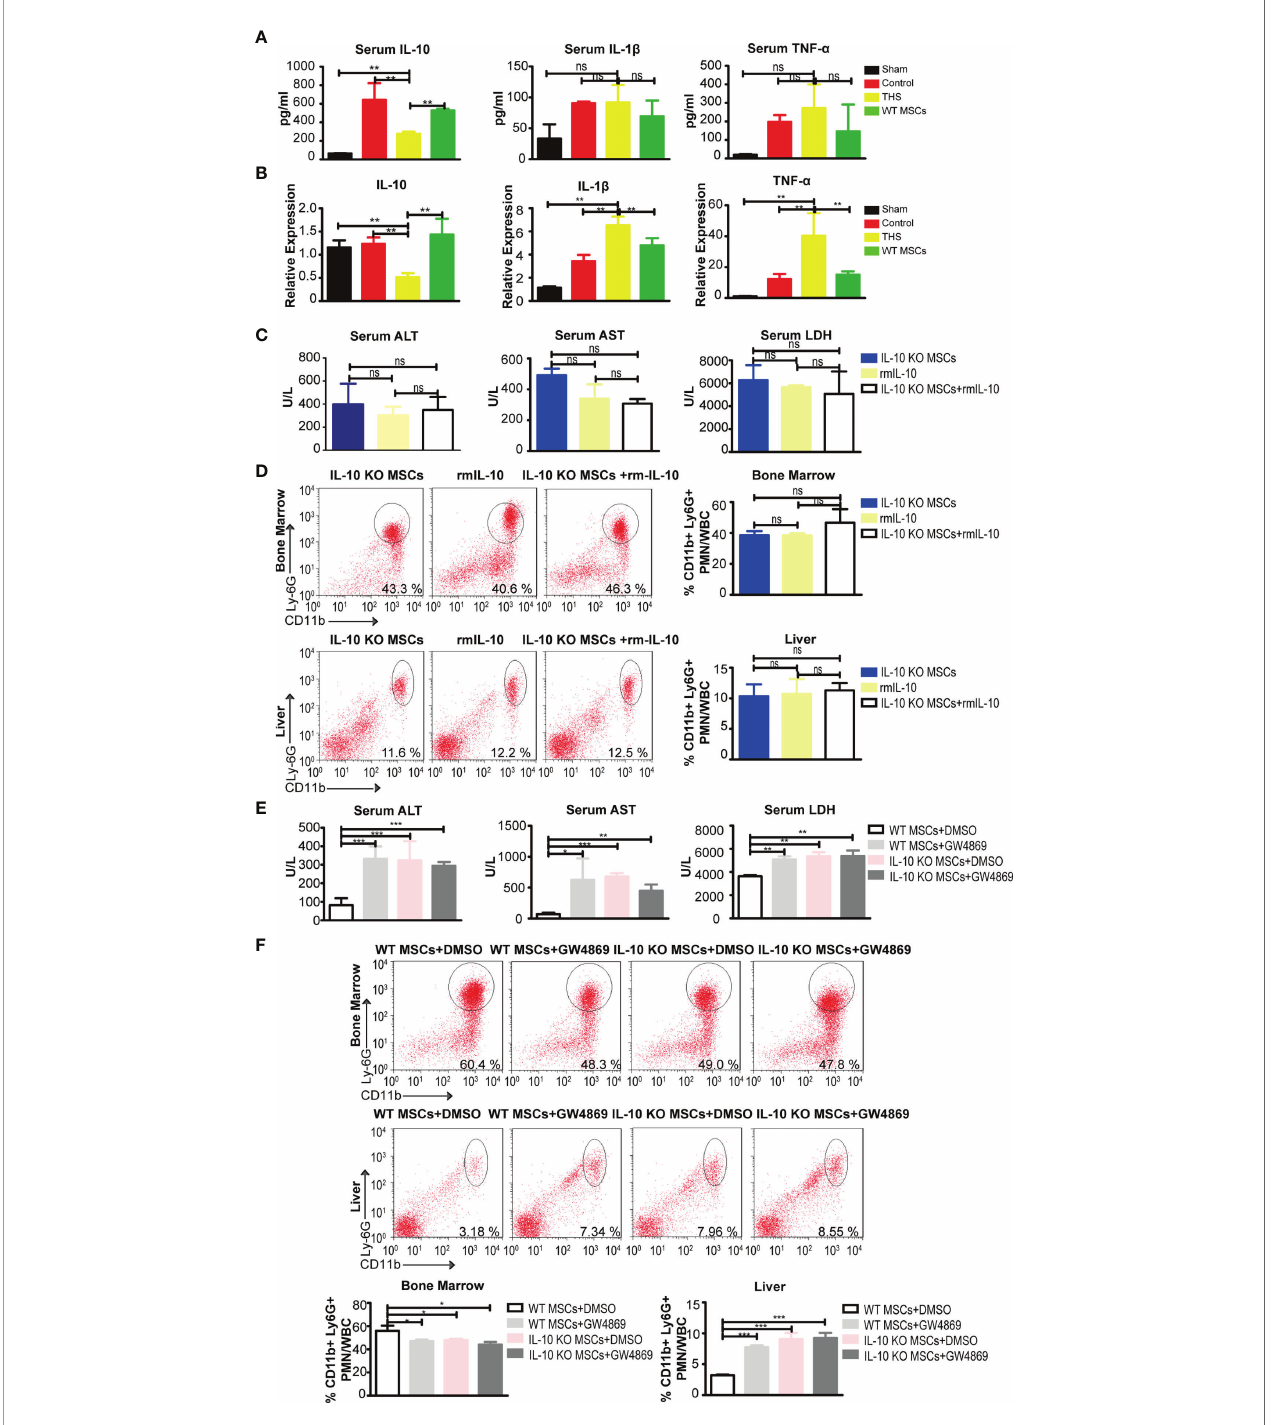
FIGURE 2 | MSC-EVs containing IL-10, but not exogenous recombinant IL-10, exhibit protection against THS in mice. (A) ELISA of TNF- a , IL-1 b , IL-6 and IL-10 levels in peripheral serum in the indicated groups (n=3 – 5). (B) Quantitative PCR analysis of IL-1 b , IL-6, IL-10 and TNF- a mRNA levels in liver tissues in the indicated groups (n=3 – 5). (C, D) After 90 min of THS, the mice received 5×10 5 IL-10 KO MSCs or 5×10 5 IL-10 KO MSCs plus 50 m g/kg recombinant IL-10 via the femoral artery at the beginning of resuscitation. (C) The serum LDH, ALT and AST levels in peripheral blood were examined in the indicated groups (n=3 – 5). (D) CD11b + Ly6G + neutrophils in bone marrow and livers were analyzed in the indicated groups (n=3 – 5). (E, F) 5×10 5 WT MSCs or 5×10 5 IL-10 KO MSCs pretreated with GW4869 (5 m g/mL) were infused into mice after THS (n=3 – 5). The serum levels of LDH, ALT and AST (E) and neutrophils in bone marrow and liver tissues (F) were measured in the indicated groups (n=3 – 5). *P < 0.05, **P < 0.01, ***P < 0.001; ns, not signi fi cant. All data are shown as the one-way analysis of variance of the